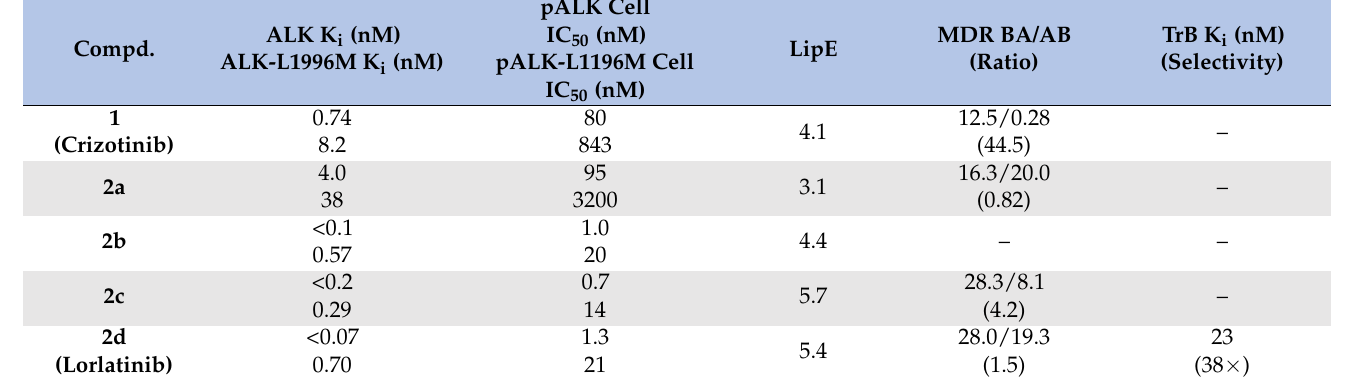
Table 1. Biological and physicochemical profiles of macrocyclic ALK inhibitors